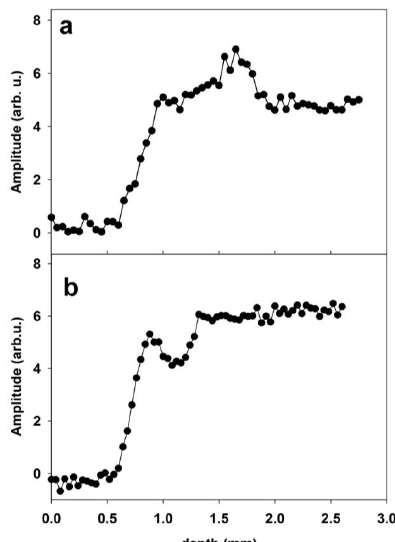
Figure 11. ( a ) Single-sided NMR collecting a stratigraphy of the Madonna Hodigitria icon. ( b , c ) Details of two regions of the icon measured by NMR. Adapted from [19].